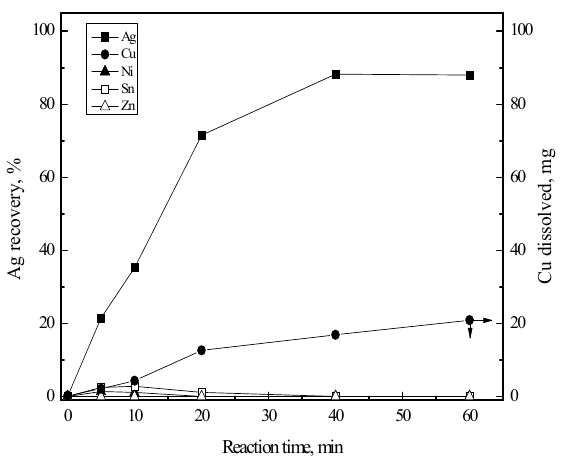
Figure 7. Effect of reaction time on the Ag recovery by cementation with Cu sheet. Stirring speed = 200 rpm; temperature = 80 °C; time = 0–60 min; copper sheet = 50 × 12.5 mm 2 .